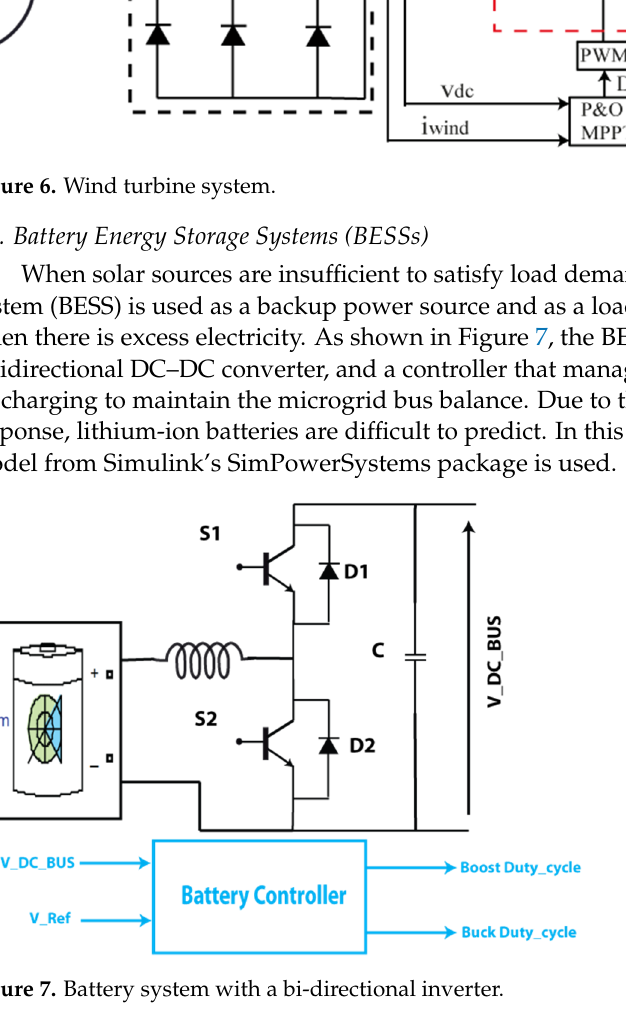
Figure 7. Battery system with a bi-directional inverter.